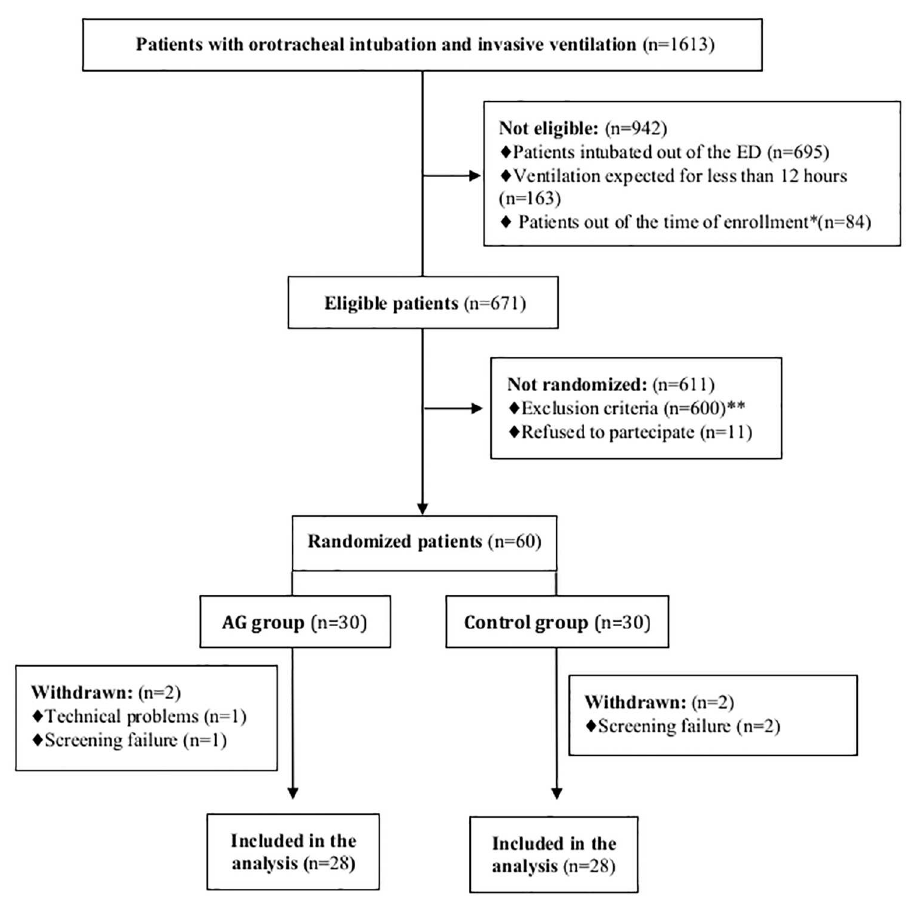
Fig 1. Flow chart of study inclusion process. ED , Emergency Department; BMI , Body Mass Index * Patients connectedto either AG 110 system or subglotticsuction system after 6 hours from tracheal intubation ** The reasonsfor excludingpatients at admission were: suspicionof pneumonia and lung contusionon chest X ray (n = 375); mechanicalventilation duringprevious three months (n = 58); facial, oropharingeal and neck trauma (n = 123); difficult intubation(n = 28); BMI > 40 (n = 16).